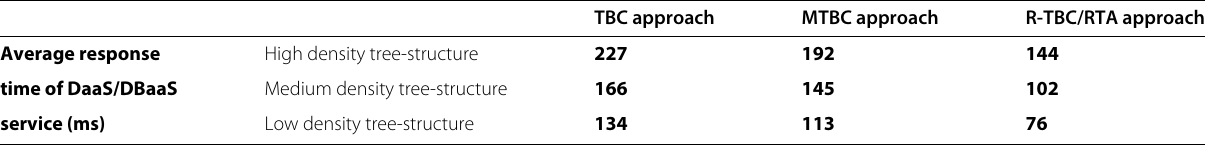
Table 5 Average response time (ms) of DaaS/DBaaS service with various density of tree structure using standard 70/30 ratio